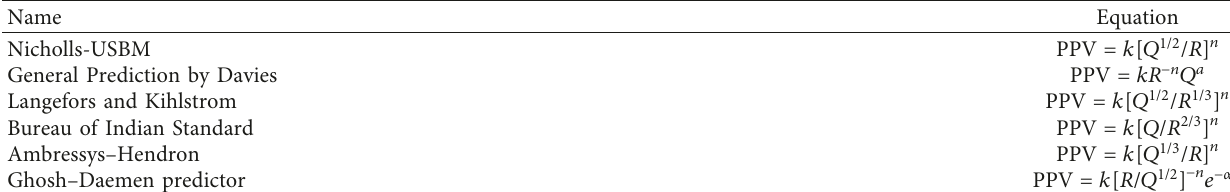
Table 2: Empirical PPV predictor presented by different